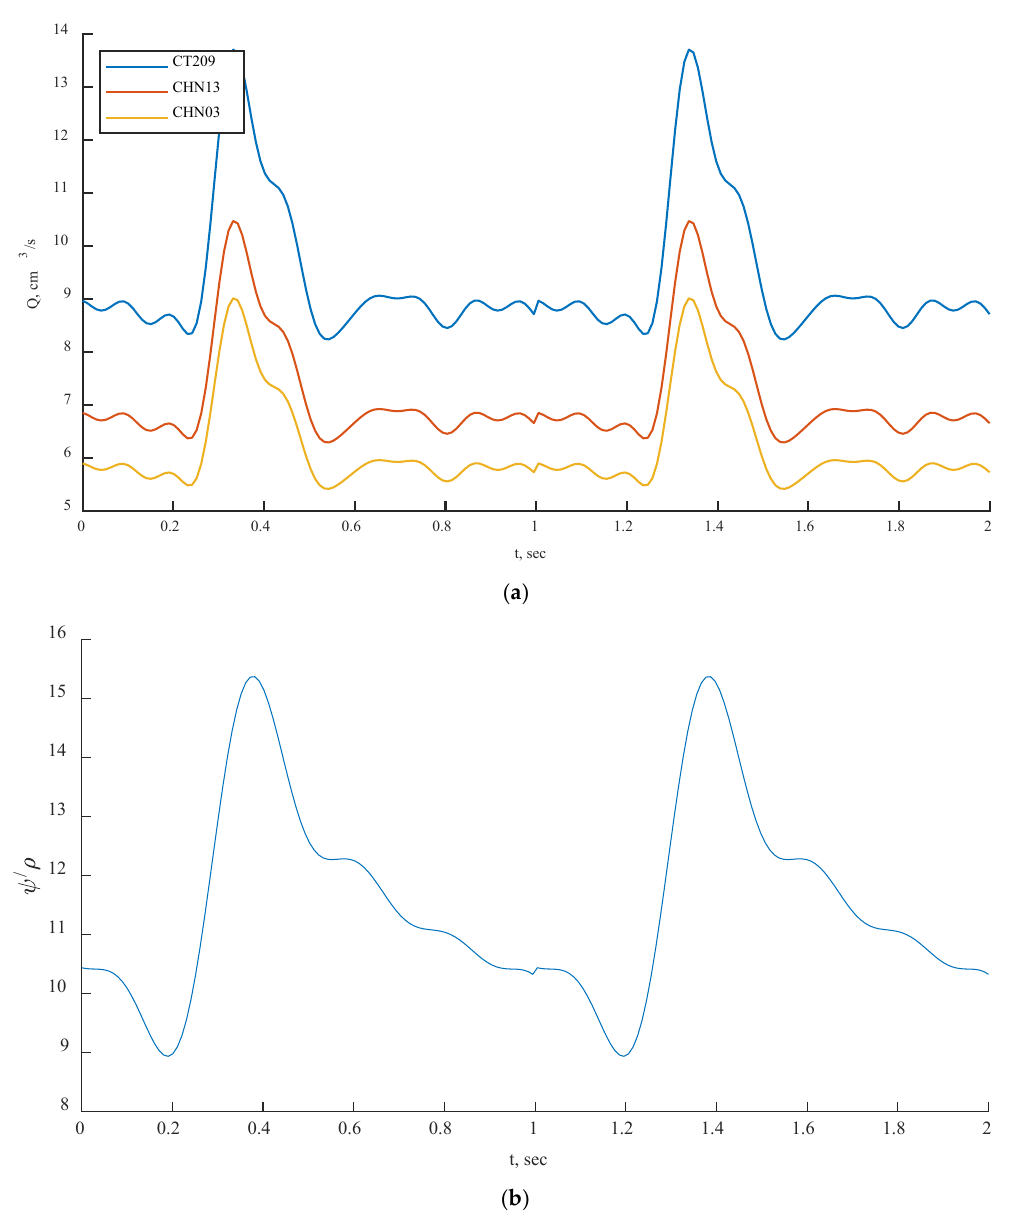
Figure 6. Inlet boundary conditions: transient flow rate ( a ) and normalized pressure ( b ) waveform of coronary blood flow.